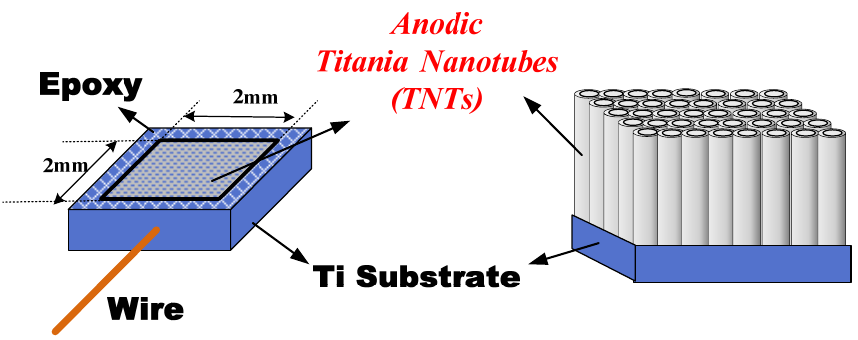
Figure 1. Planar view and cross section of the anodic titania nanotube array film electrode